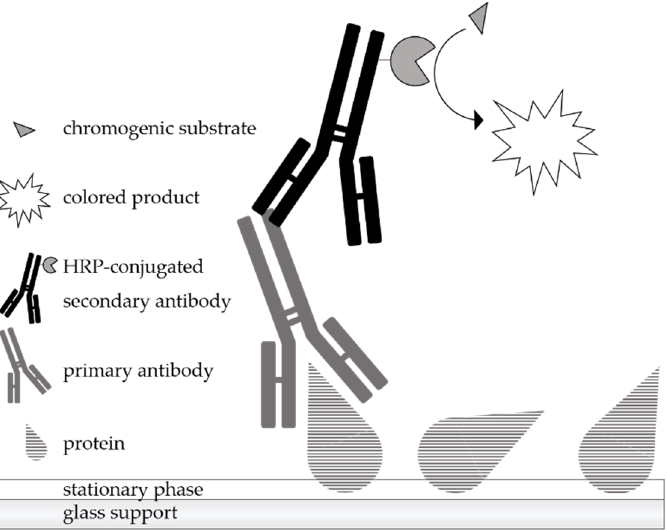
Figure 1. Schematic representation of the principle of an indirect antibody-based detection of proteins after chromatographic separation (HPTLC-IS). The primary antibody having affinity for the target protein is associated with the HRP-conjugated secondary antibody specific for the host of the primary antibody. Visualization of the ligated antibodies is achieved by the formation of a colored precipitate derived from a chromogenic substrate.